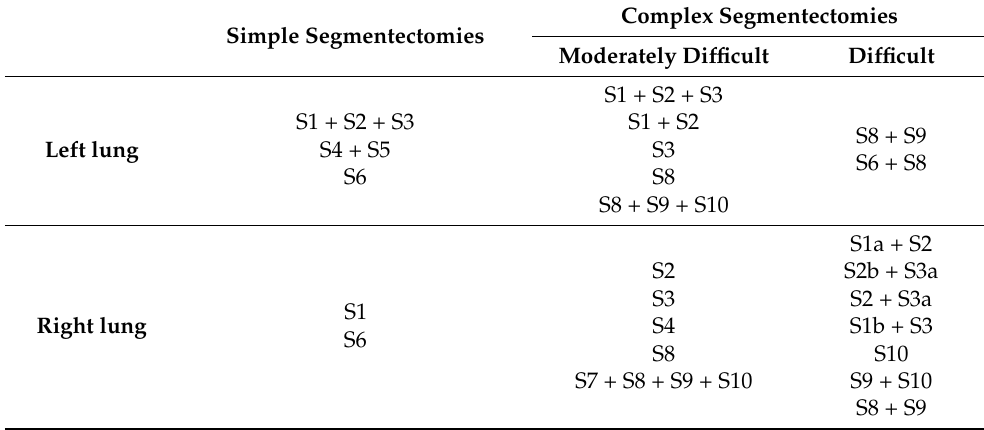
Table 1. Classification of simple and complex segmentectomies [9]. Complex Simple Segmentectomies